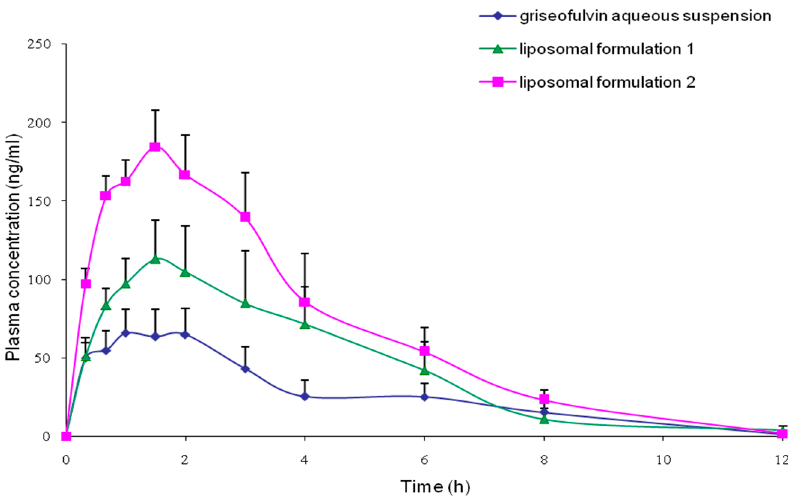
Figure 2. Mean plasma griseofulvin concentration versus time profiles after dosing with griseofulvin aqueous suspension, F1 and F2 (8 mg/kg) (Mean ± SEM, n = 9).